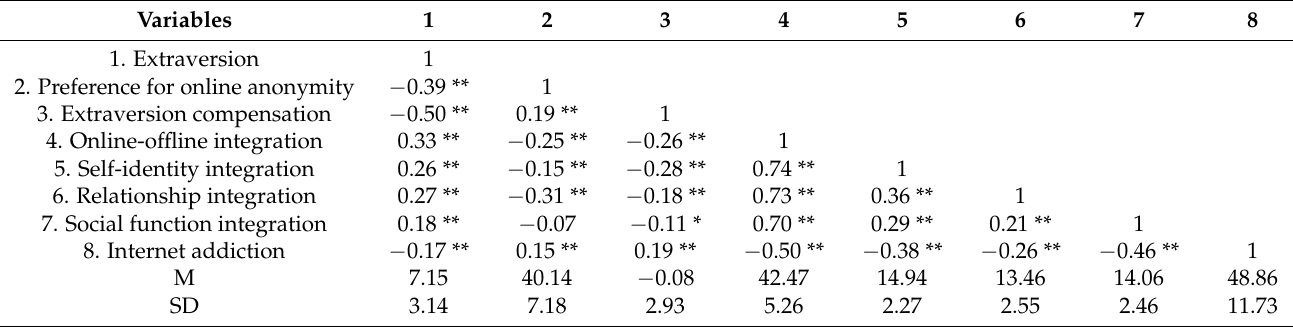
Table 1. Means, standard deviations, and correlations between variables (n = 428).